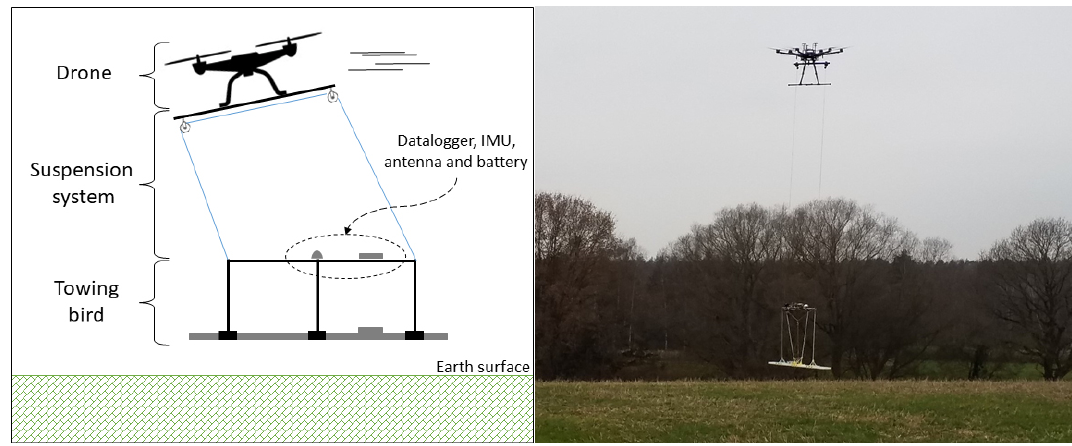
Figure 1. An illustration on the left of the drone set-up and a picture from a field survey in Falster,